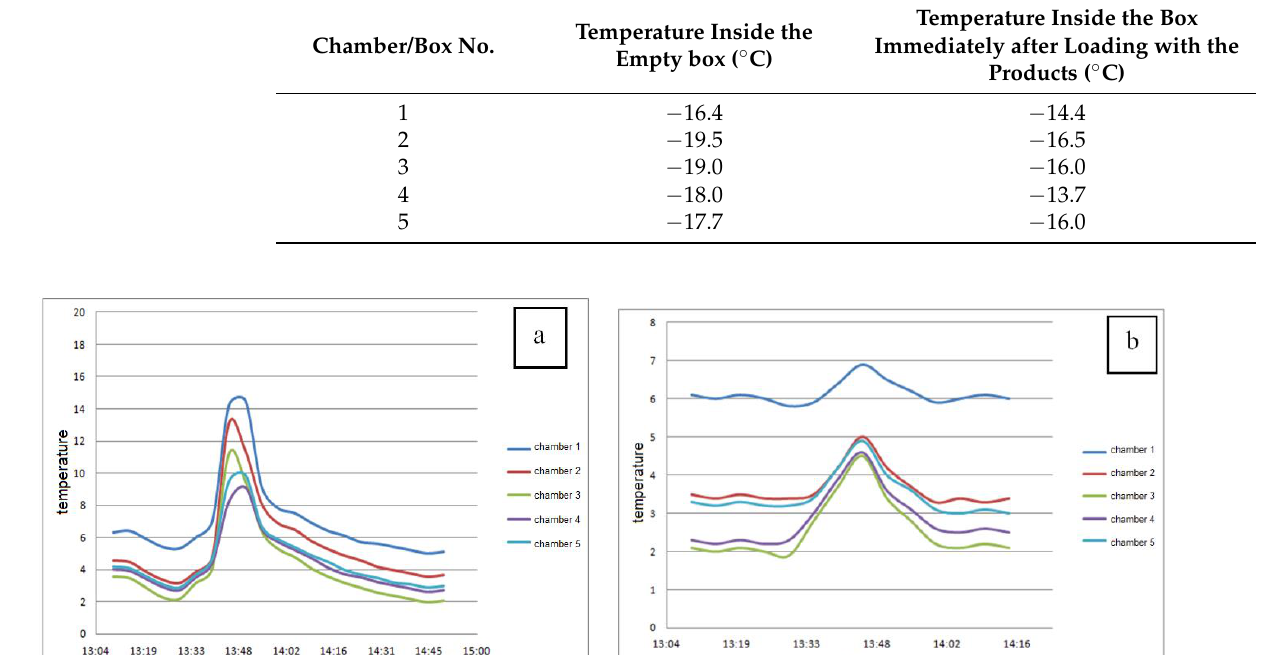
Table 3. Temperatures in individual freezing module boxes during product loading.